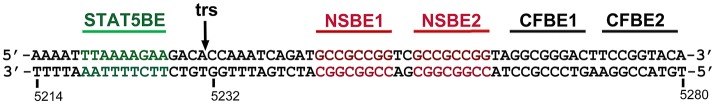
A diagram of the B19V minimal origin of viral DNA replication (Ori). B19V has a 67-bp long minimum origin of DNA replication (Ori) at each end of the genome. Ori harbors two NS1 binding elements (NSBE1&2, in red), one STAT5 binding element (STAT5BE, in green), a terminal resolution site (trs, black), and two potential cellular factor binding elements (CFBE1&2). Question marks denote two unidentified host factors binding Ori.